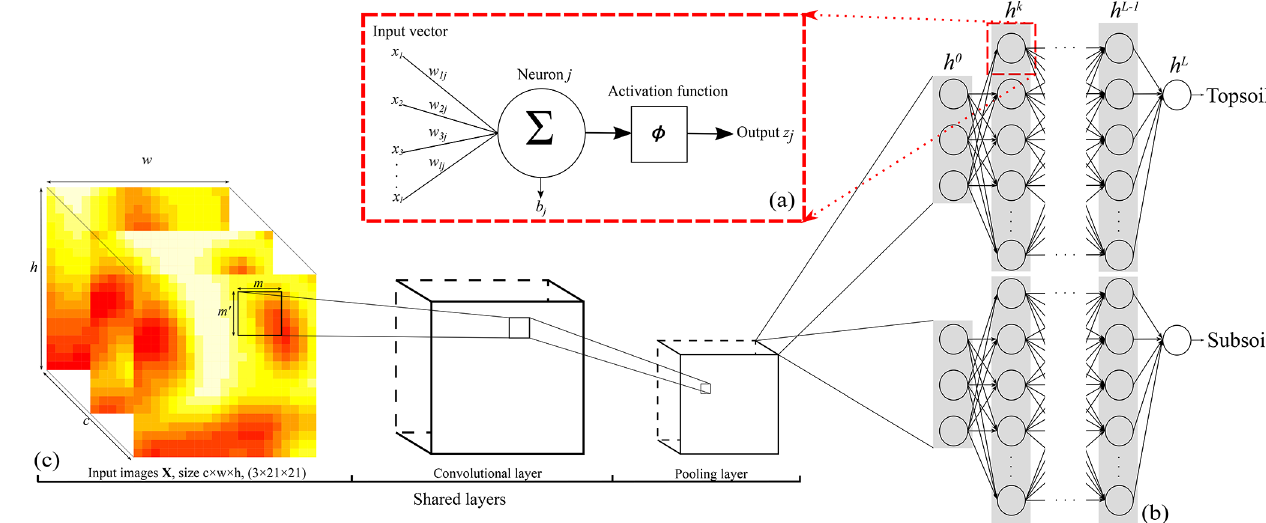
Figure 1. Representation of the CNN architecture developed in this study for (a) a neuron, (b) the ANN architecture or fully connected layer, and (c) the convolutional and pooling layers. Note that P = (cid:104) w j , x (cid:105) . The size of the output from a convolutional or pooling layer (c) is smaller than that of its input. Panel (c) is the shared structure to extract common features between the two depths which is then separated into two branches (one per soil depth) in (b)